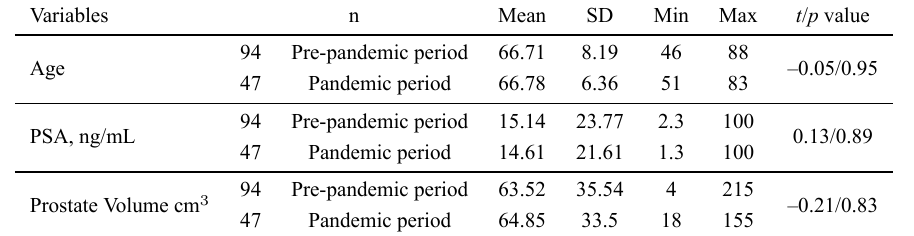
PSA, prostate specific antigen; SD, standard